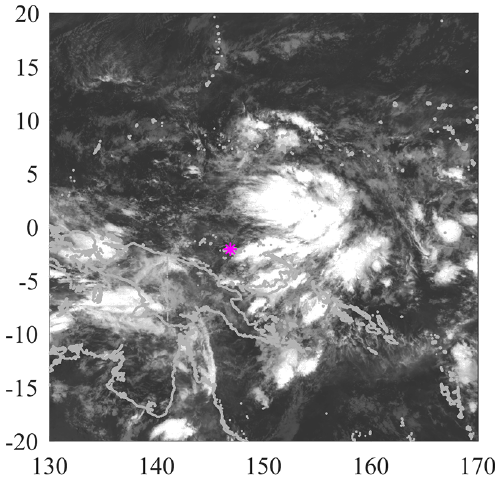
Figure 1. Contour plot of ozone concentrations from the Manus ozonesondes. The white lines are potential temperature isolines. Note the very low concentrations in the upper troposphere around 21–22 February. Green bars along the top denote launch times of ozonesondes. For further details, see Newton et al. (2016).